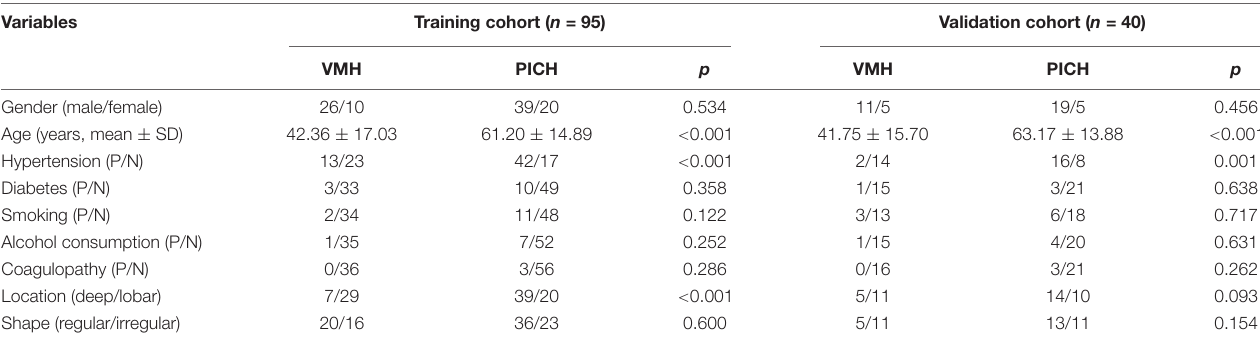
TABLE 1 | Demographic data and NECT